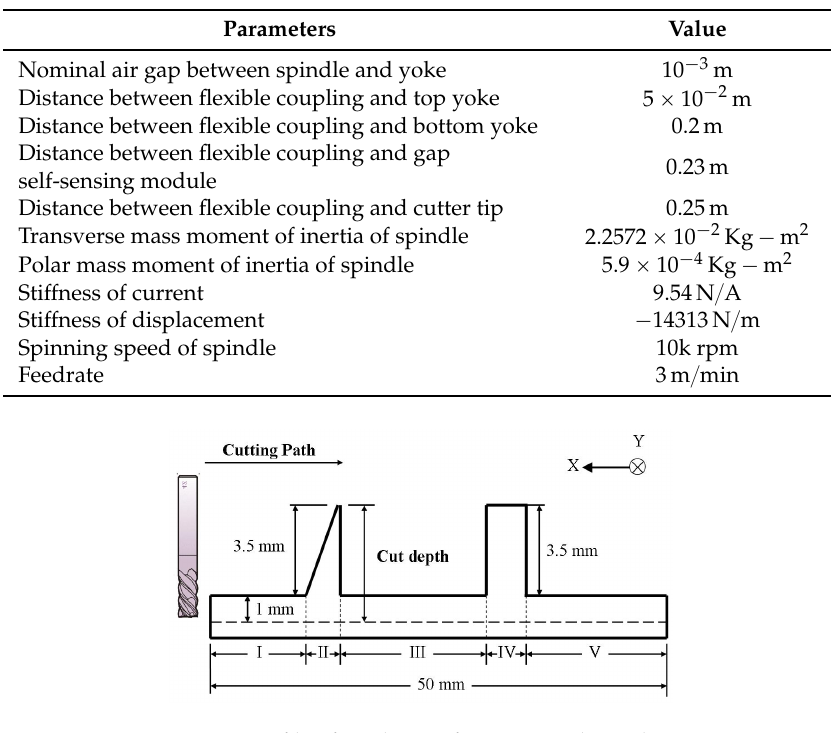
Table 2. Parameters of milling operation and ECAMA/spindle system for numerical simulations.